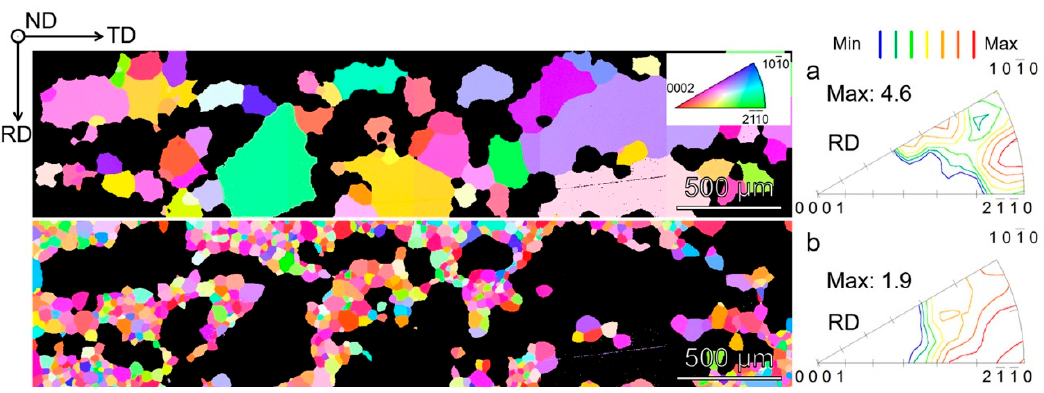
Figure 11. EBSD IPF maps and corresponding inverse pole figures showing textures of ( a ) abnormally coarse grains and ( b ) normal ‐ size grains in the T4 ‐ treated Mg–1.5Ag–0.1Ca alloy sheet.